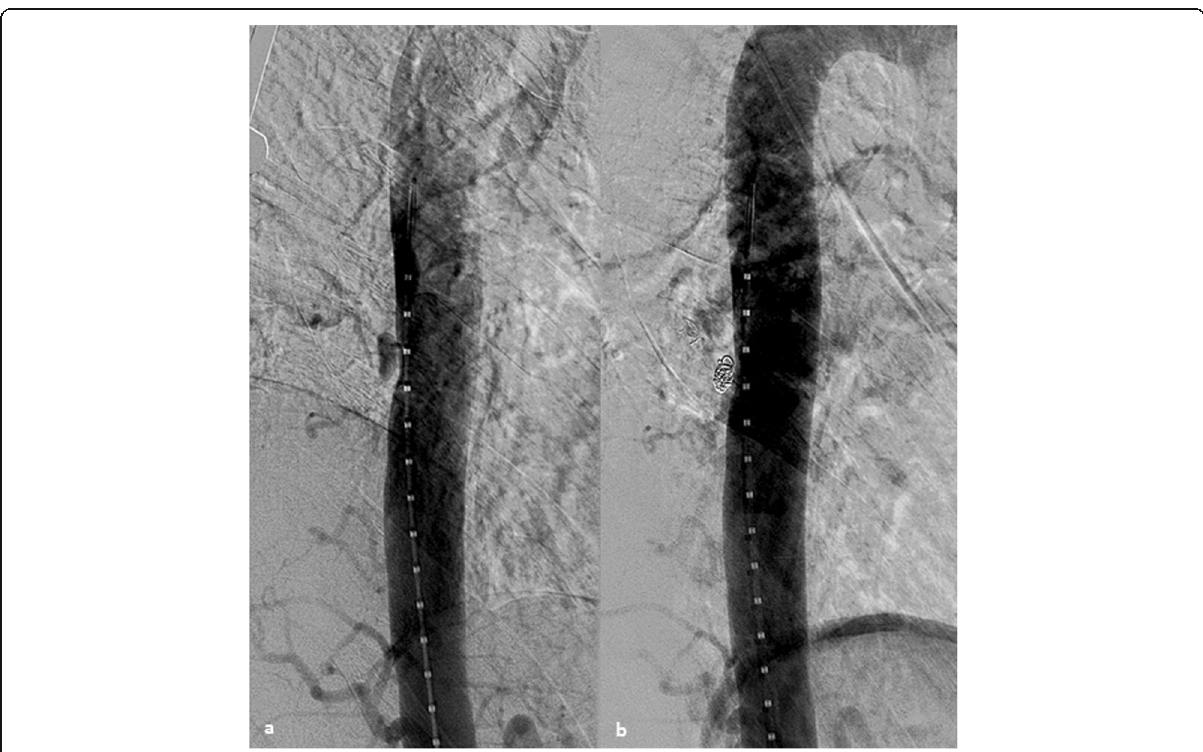
Fig. 3 a , c Axial and sagittal images demonstrating intramural aortic haematoma with branch artery pseudoaneurysm at TH8 level. b , d Evidence of successful embolization after 21 months of follow, there are no signs of complication or re-filling of the pseudoaneurysm. e Flouroscopic image showing the coil-deployment inside the branch artery